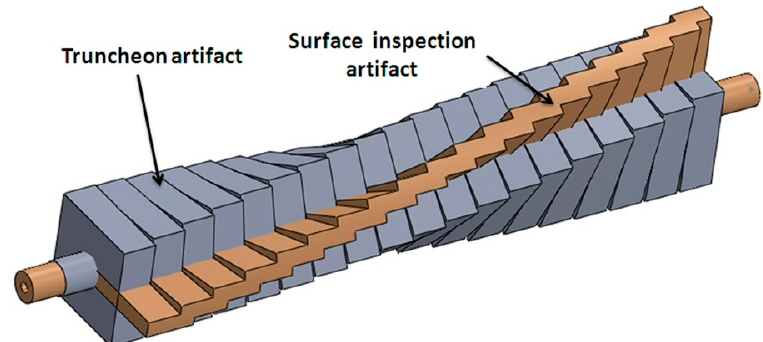
Figure 10. Comparison between the new test artifact and the truncheon artifact with the same dimensions of the flat surface to be measured.